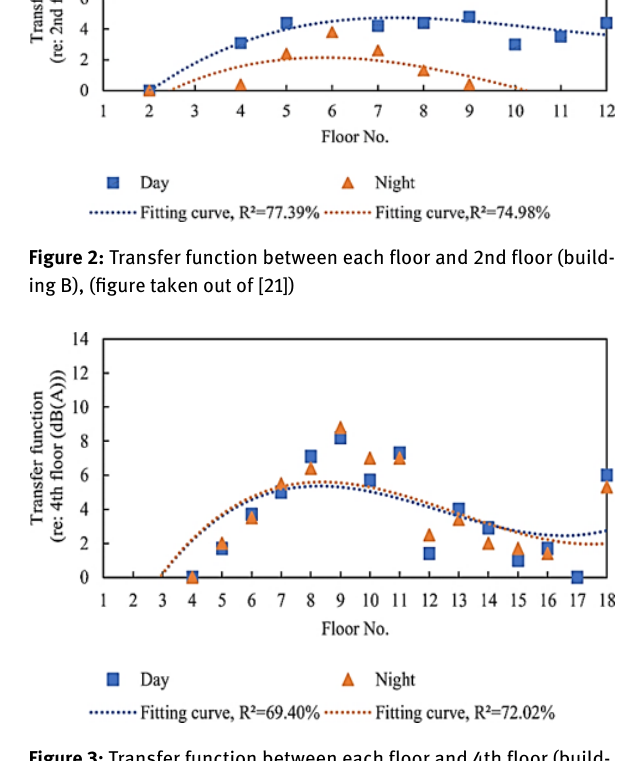
Figure 3: Transfer function between each floor and 4th floor (build- ing C), (figure taken out of [21])